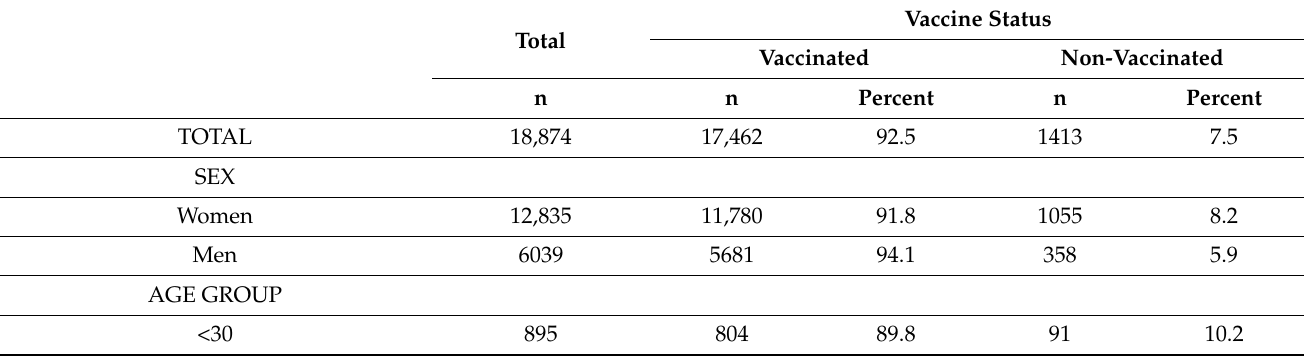
Table 2. Vaccination status by participant characteristics.